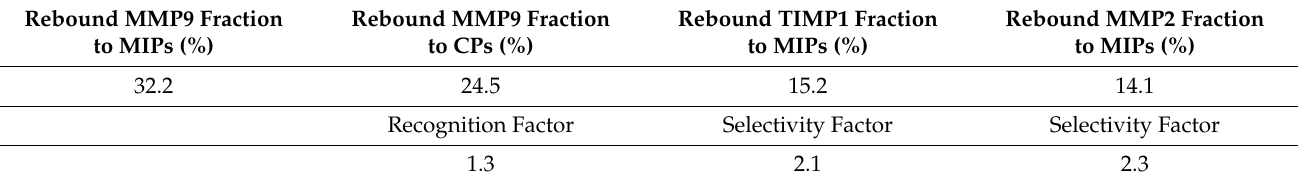
Table 1. Recognition and selectivity values of